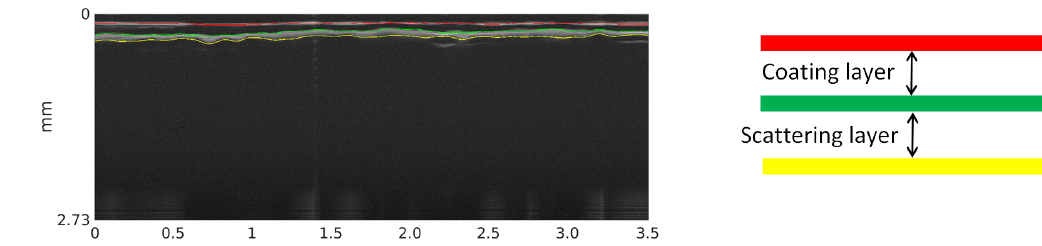
Figure 3. OCT B-Scan of corroded metal (sample 8): red line is the top of the coating layer, green line determines the end of the coating and the beginning of the corrosion, yellow line determines the end of the scattering-induced layer. Axes are given as optical path length n × d